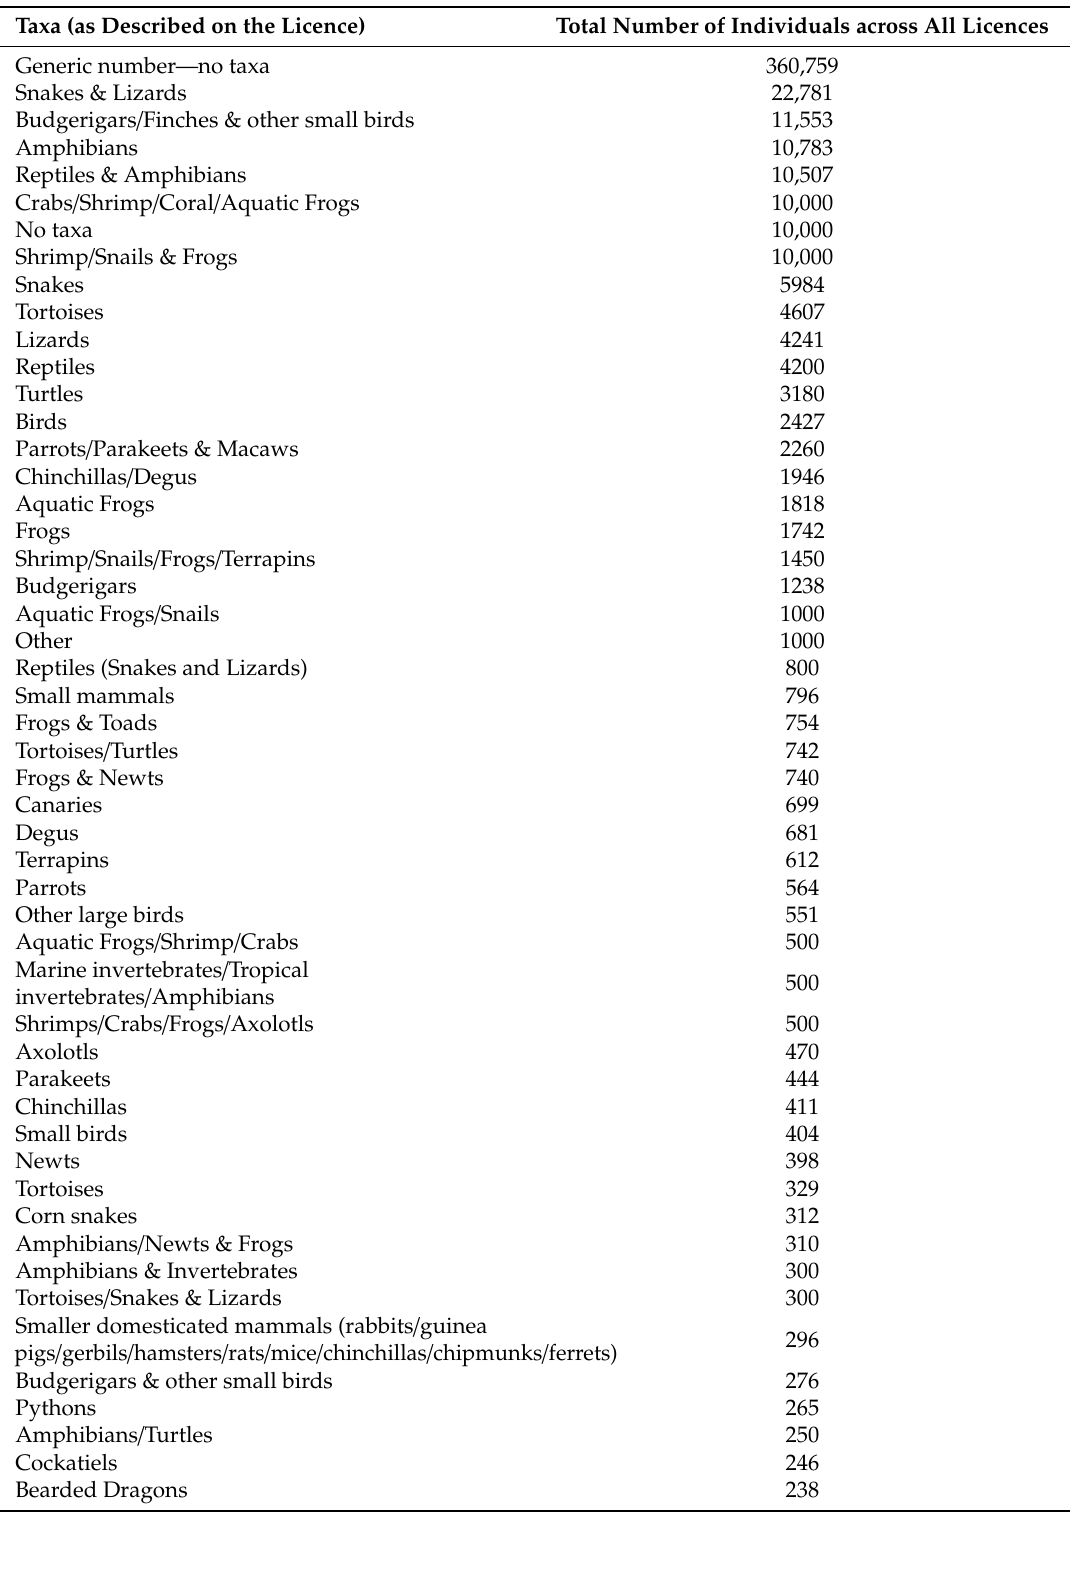
Table A3. Maximum number of individuals of each taxonomic description permitted for sale in 2019 as listed across all